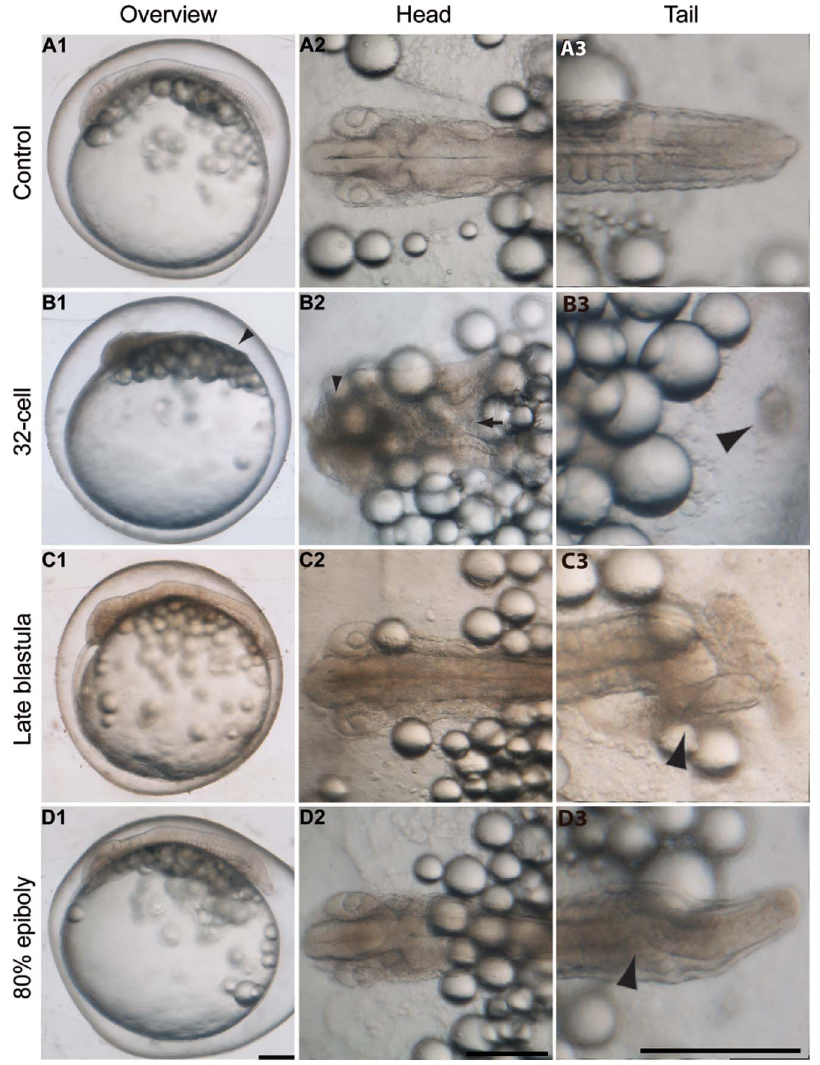
Figure 1. Stage specific inhibition of Bmp in K.marmoratus . Embryos were exposed to 100 m M dorsomorphin at the 32-cell ( B ), late blastula ( C ) and 80% epiboly ( D ) stages of development. Photographs of the embryos were taken 3 days post-fertilization. A1–3 : Control (n=20/20). B1–3 : splitbody (phenotype variation details in Figure 3), this phenotype is characterised by absence of a distinct tail region ( B1 arrowhead), morphologically undifferentiated head region ( B2 arrowhead) and split body axis ( B2 arrow), and cell islands in the posterior region ( B3 arrowhead). C1–3 : Curled tail (n=8/10), this phenotype resembles snailhouse seen in zebrafish and is characterised by its curled tail ( C3 arrowhead). D1–3 : Bent tail (n=12/12, this phenotype primarily displayed a bent tail ( D3 arrowhead). Overview images are lateral views and head/tail images are dorsal views of the embryos. Scale bars: 250 m m.